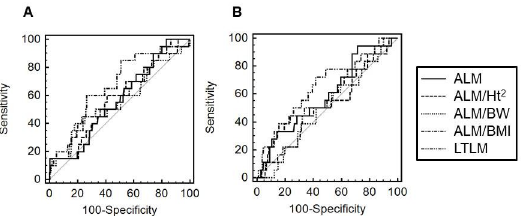
Fig 1. AUROC values for various indices used in prediction of mortality at 1 year after PD initiation (A: men, B: women). Abbreviations: AUROC, area under the receiver operating characteristic curve; PD, peritoneal dialysis; ALM, appendicular lean mass; ALM/Ht 2 , appendicular lean mass per height squared; ALM/BW, appendicular lean mass per body weight; ALM/BMI, appendicular lean mass per body mass index; LTLM, limb/trunk lean mass ratio.